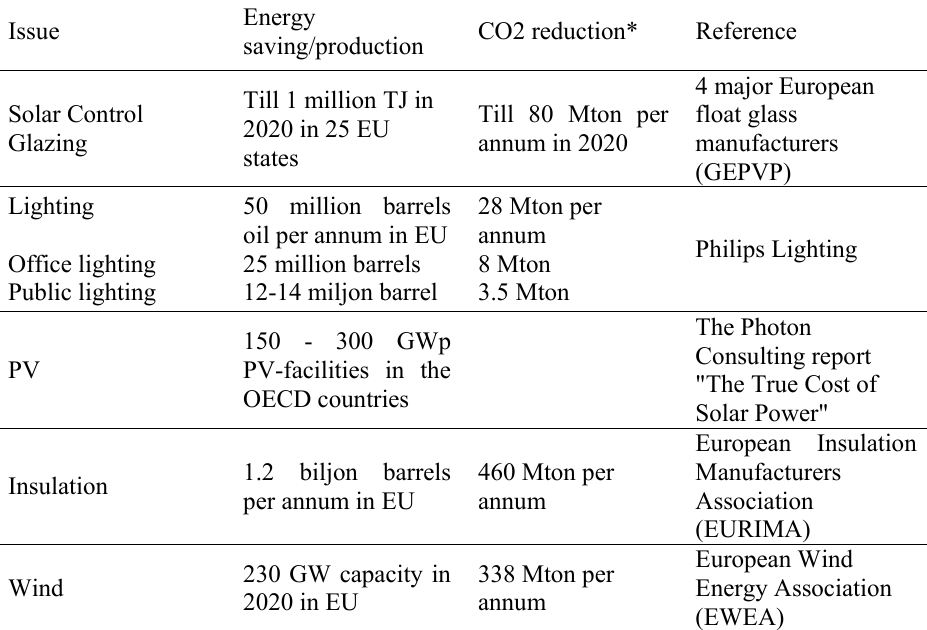
Table 1: expected energy savings and carbon reductions in Europe related to some actions of the survey